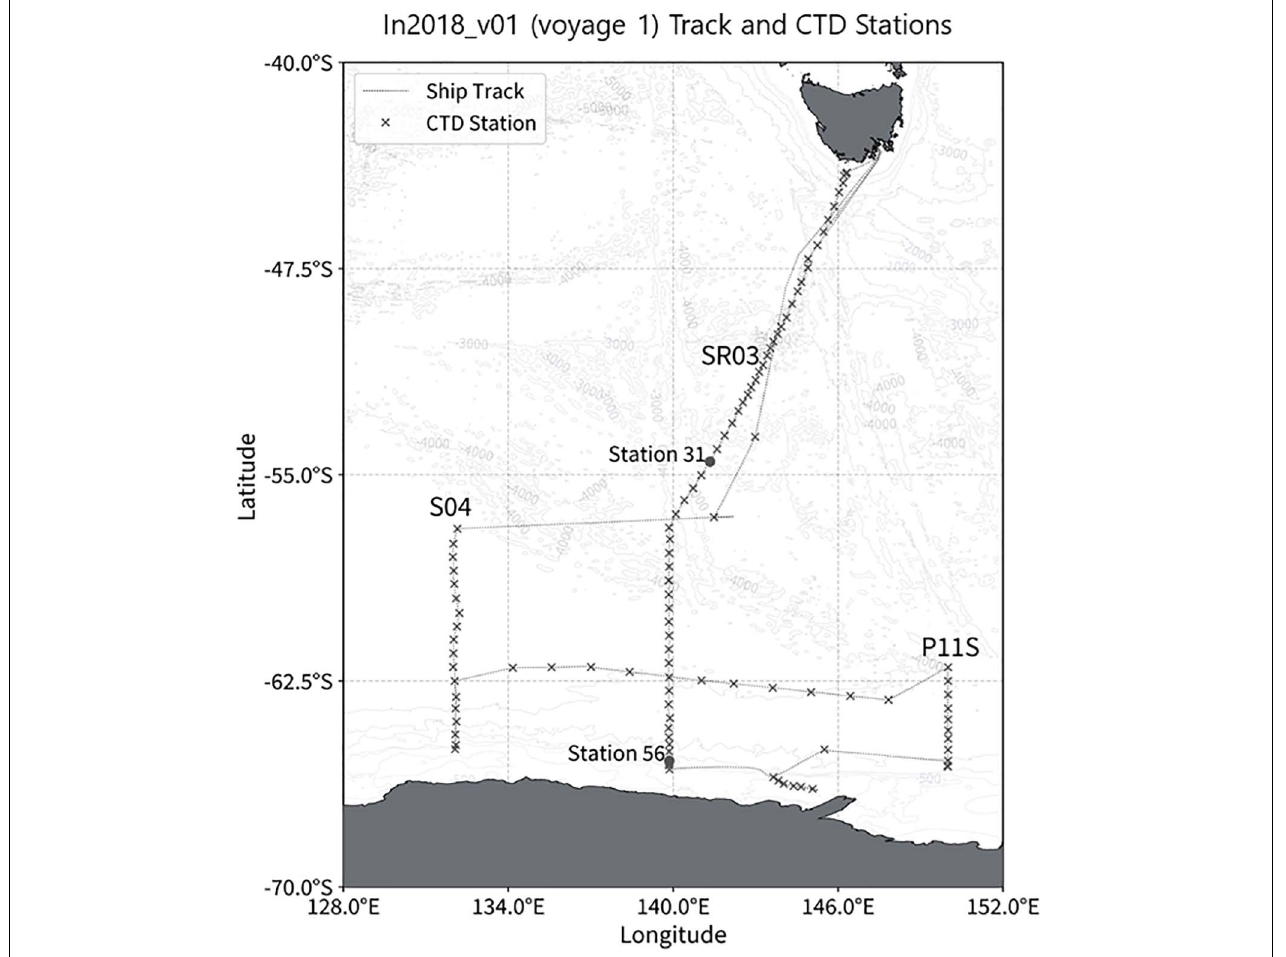
FIGURE 3 | Flow diagram summarizing the preparation and storage of internal QC’s prior to voyage 1 and voyage